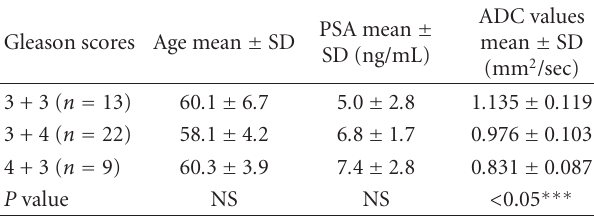
Table 1: Patient clinical information and ADC